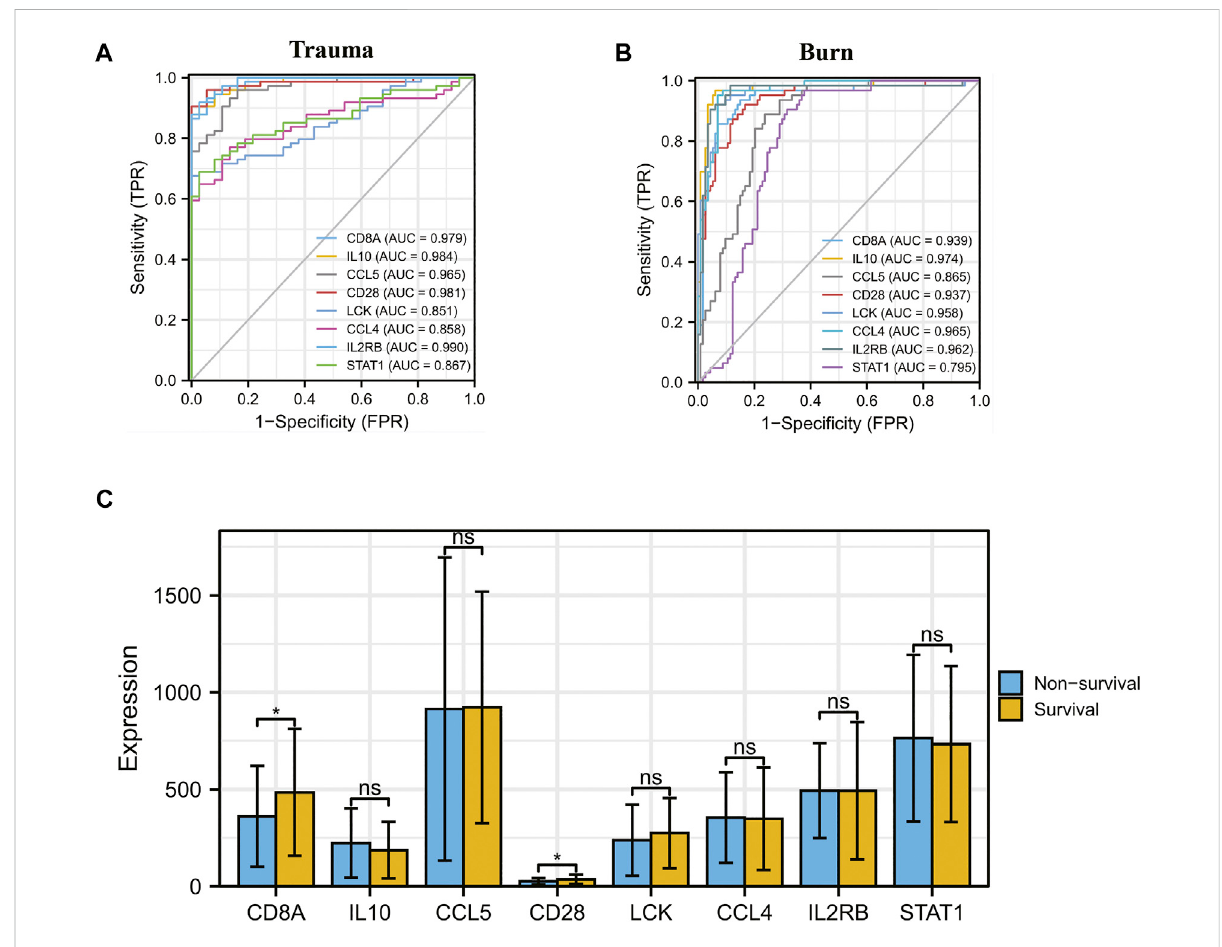
FIGURE 9 (A,B) ROC curve analysis of core immune-related DEGs in blunt trauma and burns. (C) Differences in expression of core immune-related DEGs between survival and non-survival of burns